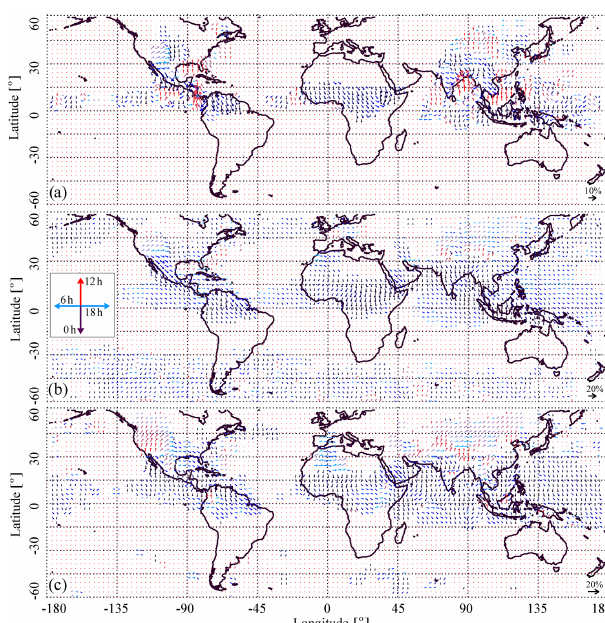
Figure 6. Same as Fig. 5, but for averaged July (2008 through 2015).